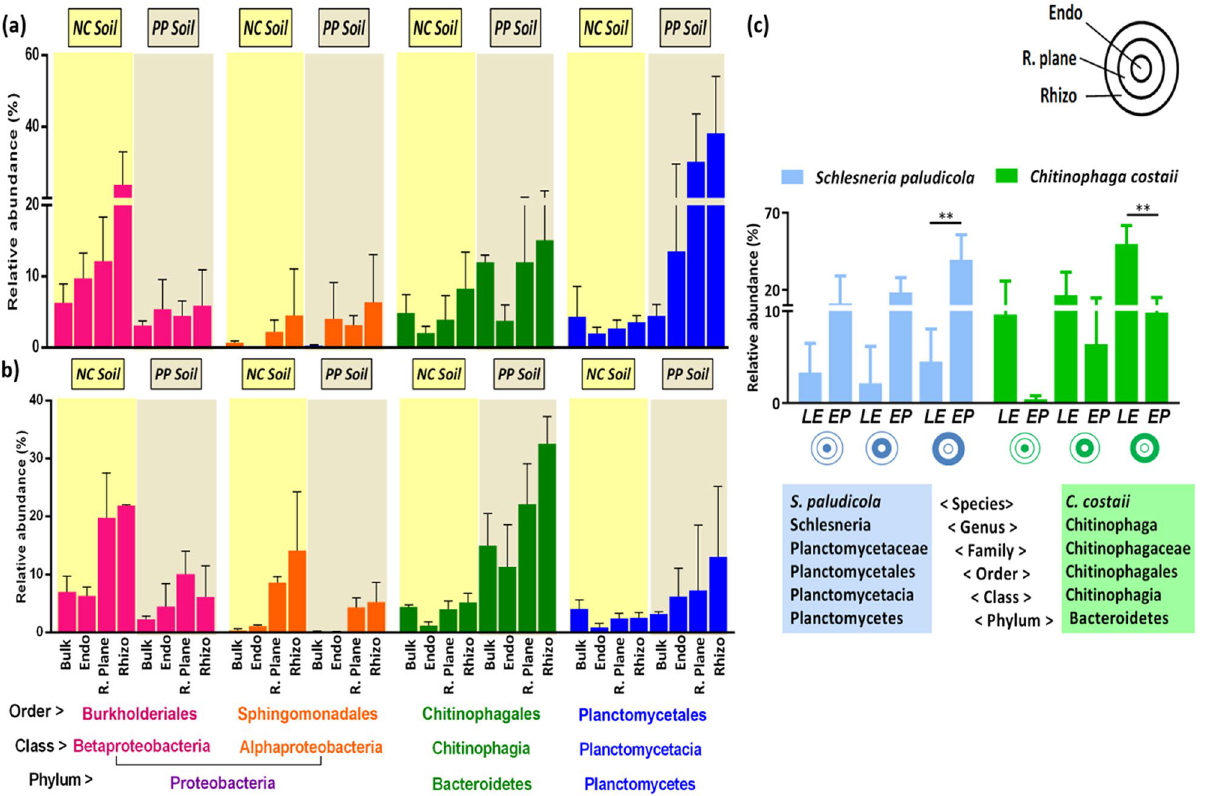
Figure 4. Differentially enriched/deriched OTUs at Order level in; (a) E. plantagineum (EP), and (b) L. erythrorhizon (LE) rhizo-compartments under the influence of natural campus (NC) and peat potting artificial (PP) soil. (c) Differentially expressed species in rhizosphere, rhizoplane, endosphere compartments of both EP and LE under the influence of PP soil only. Error bars represent standard deviation (SD) from the mean (n = 3). **Represents significant difference ( P < 0.005) among microbes colonizing EP and LE rhizosphere.